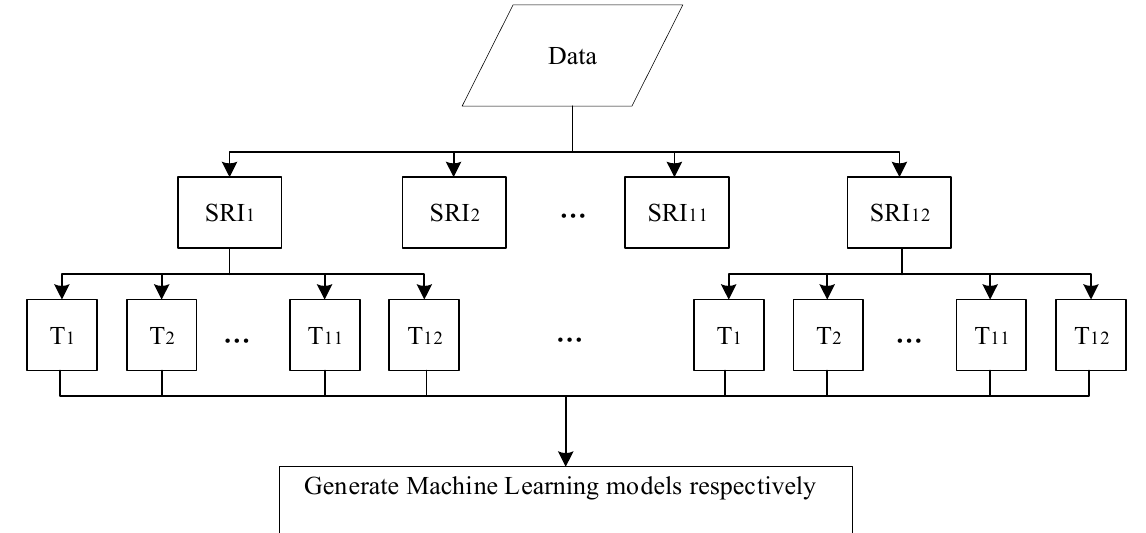
Figure 6. Flow chart of the 12 × 12 grid search method .